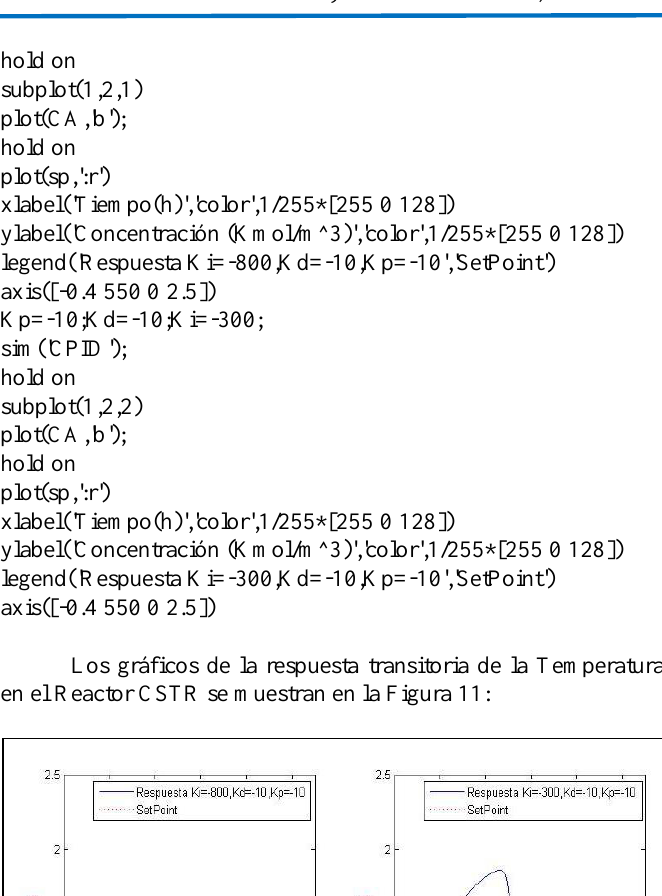
, integral K y derivativa p i